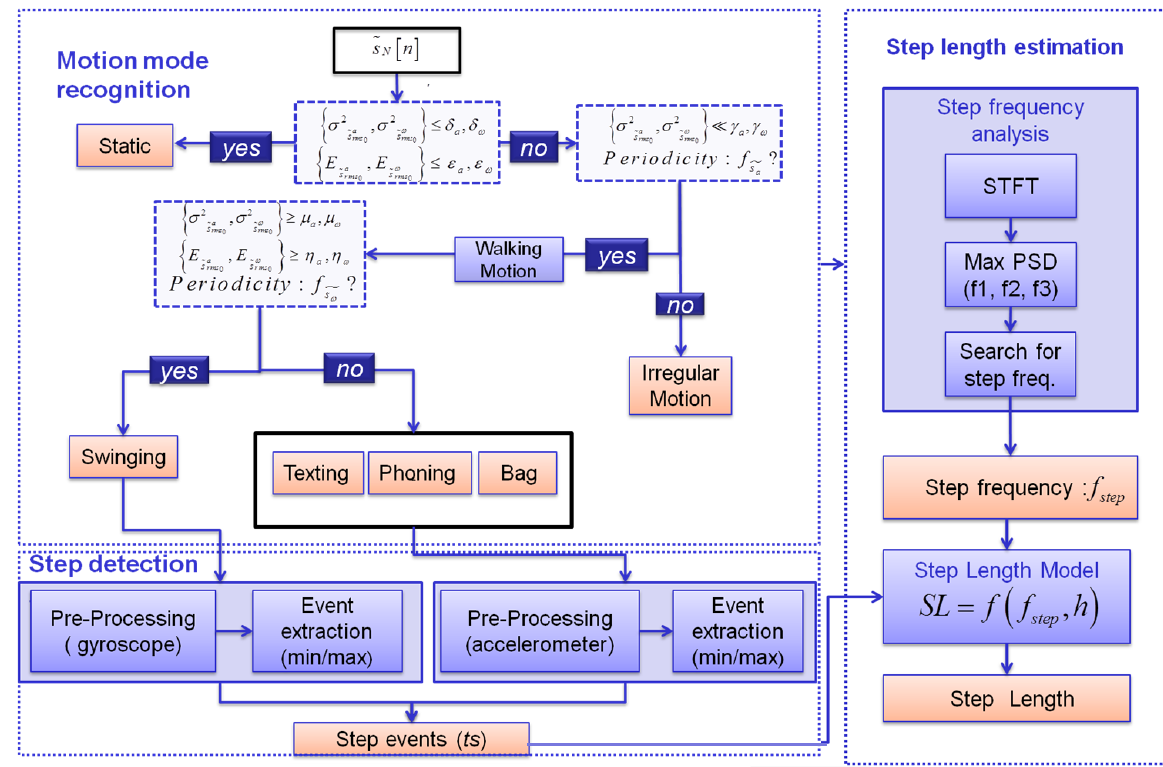
Figure 3. Block diagram of the algorithm for the user’s step length estimation using a handheld